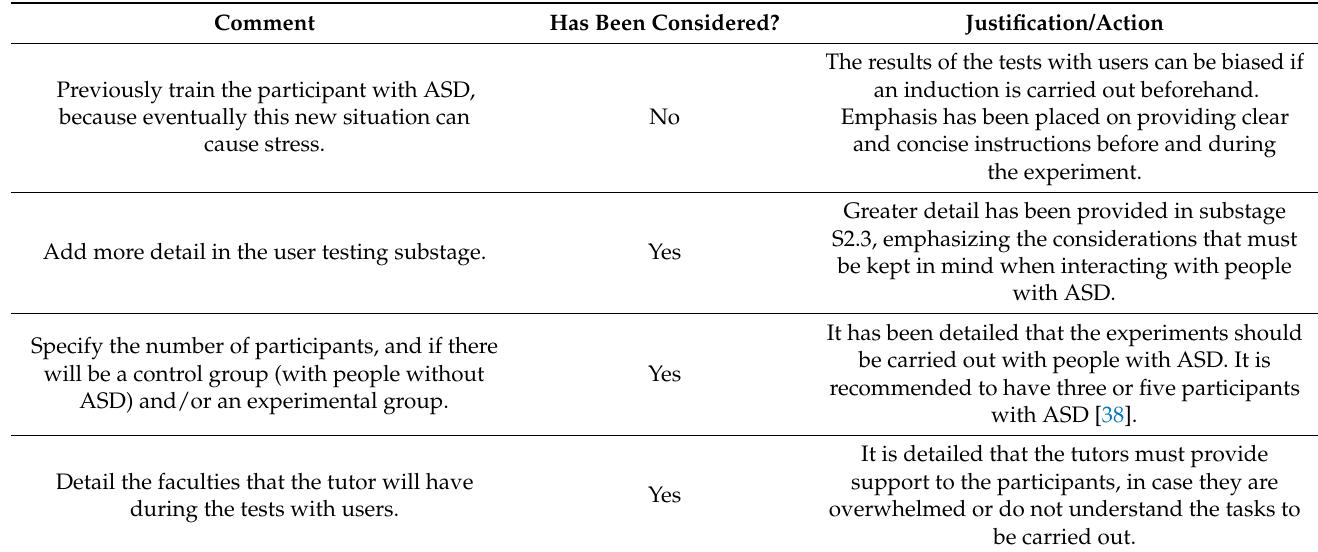
Table 3. Results of questions O1 and O2.